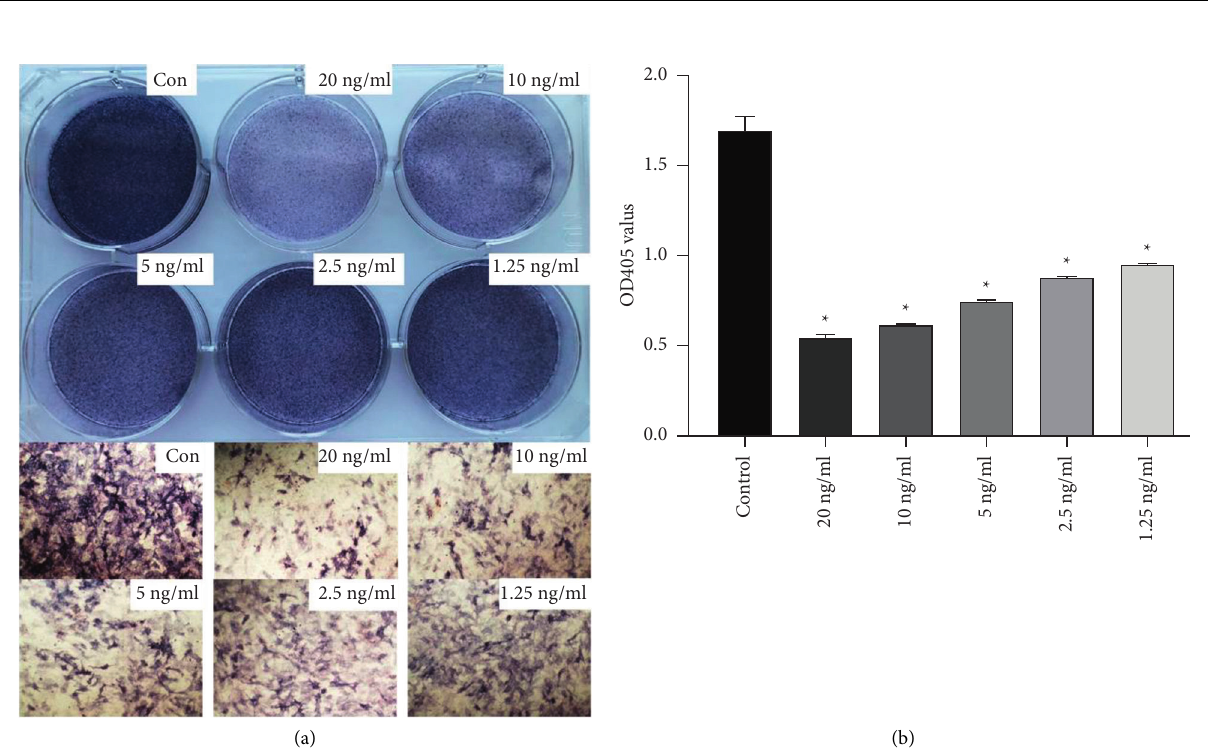
Figure 1: Comparisons of ALP staining and activities between the control and IL-1 β treatment groups (20 ng/ml, 10ng/ml, 5ng/ml, 2.5 ng/ ml, and 1.25ng/ml). (a) Osteoblasts were stained for ALP levels after being induced with the osteogenic differentiation medium for 7days (upper lanes). Details of ALP staining at day 7 (lower lanes). (b) ALP activities were detected after cell induction for 7 days. Data are expressed as mean ± SD for n � 3. ∗ p < 0.05 versus the control group.